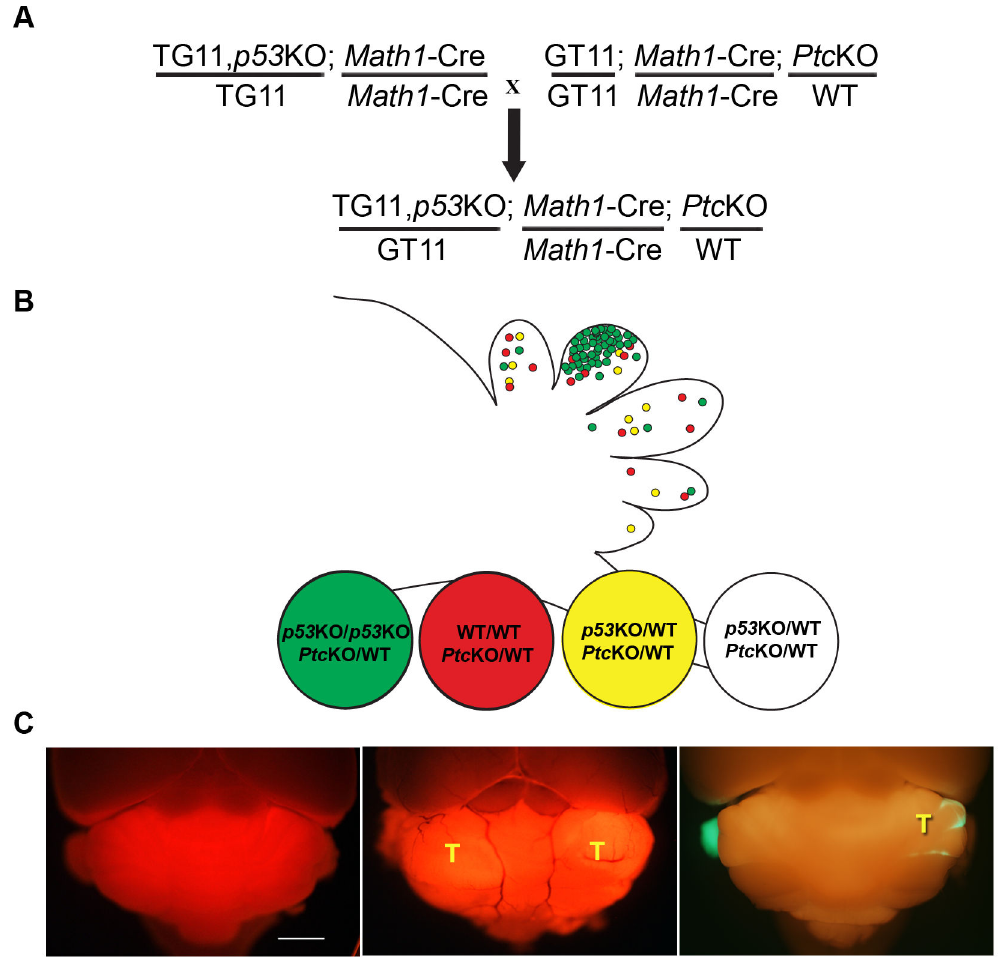
Figure 5. The generation of a medulloblastoma model with the MADM system. (A) Breeding scheme for generating medulloblastoma mouse model. (B) The correlation between fluorescent protein labeling and genotype of cells generated by MADM in this model. All cells in the animal are heterozygous for Ptc mutation but p53 status varies. Green cells are homozygous null for p53 ; red cells are homozygous WT for p53 ; yellow and colorless cells are heterozygous for p53 (KO/WT). (C) Left, a normal adult brain contains a floxed-stop Rosa-tdTomato Cre reporter and Math1 -Cre. Middle, CKO medulloblastoma model contains the same Cre line and reporter, heterozygous Ptc mutation, and homozygous p53flox alleles. Right, an early tumor formed using our